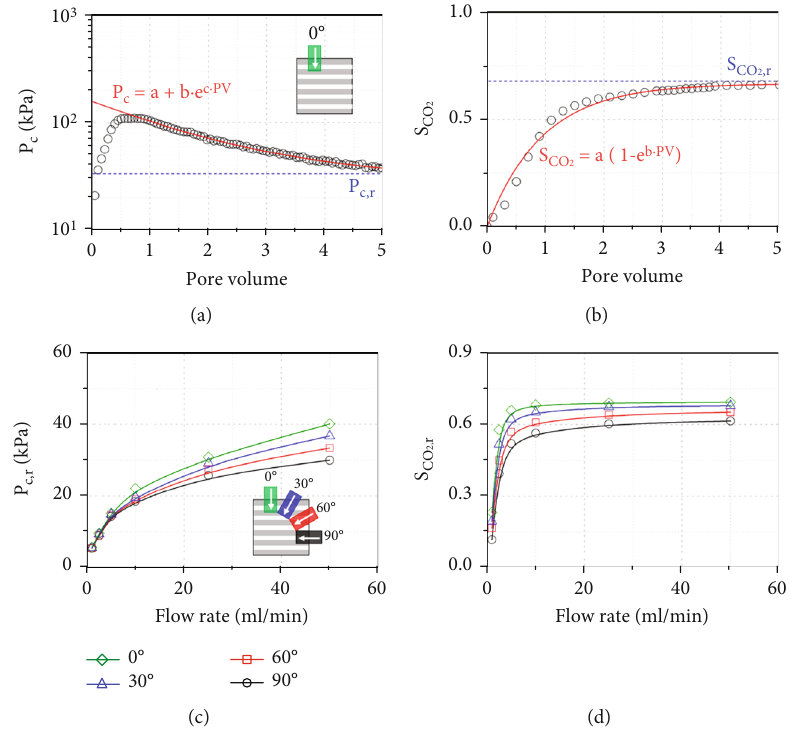
Figure 3: (a) Capillary pressure ( P for 25 ml/min. (c) Residual capillary pressure ( P scCO 2 increasing fl ow rate when injected with scCO